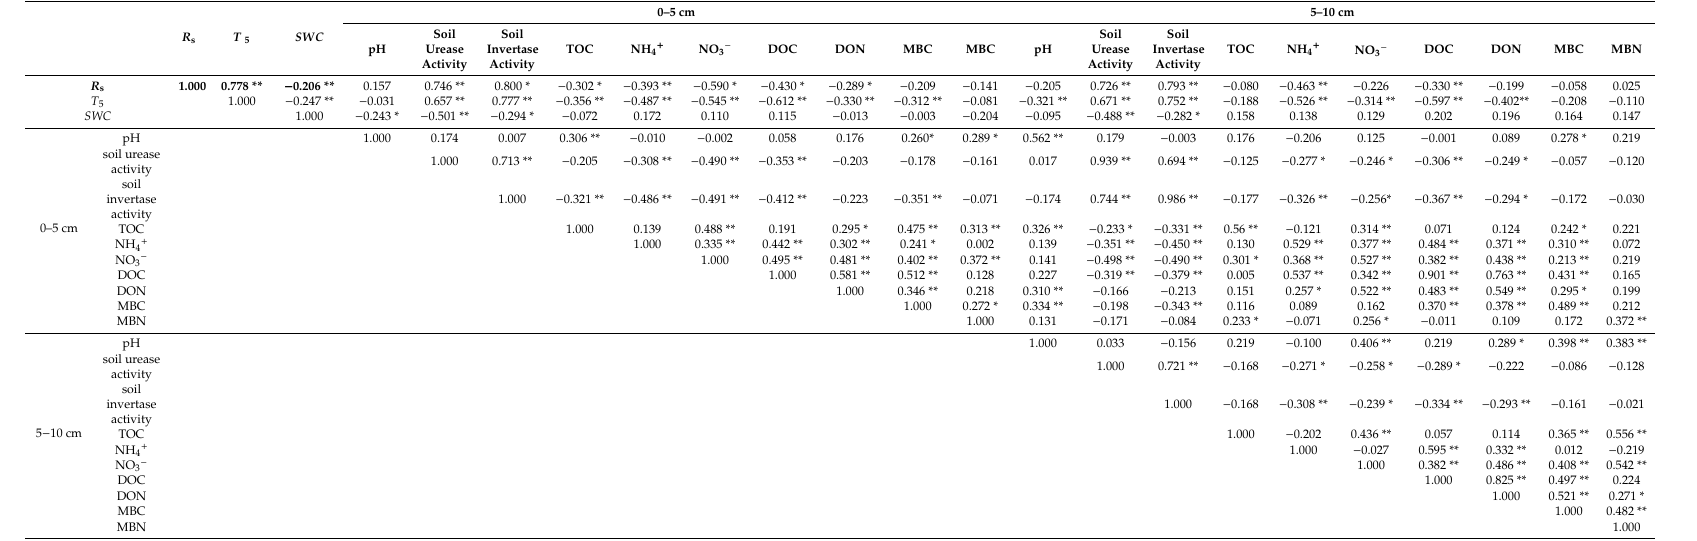
Table 4. Pearson’s correlation between soil respiration, climate factors, and soil properties. R S : soil respiration, T: soil temperature at a 10 cm soil depth, SWC: soil water content at a 10 cm soil depth, MB: microbial biomass, * p < 0.05, ** p <